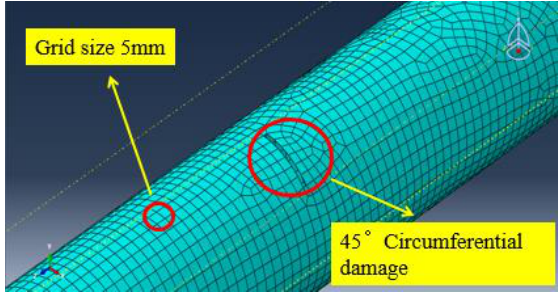
Figure 13. The pipe model meshing with 45° circumferential damage.